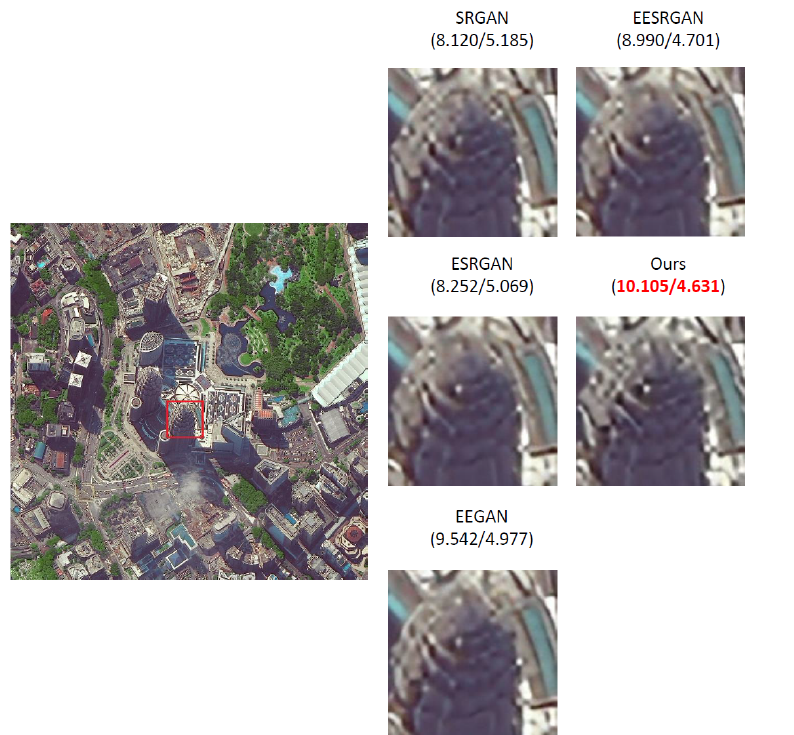
Figure 14. An enlarged partial view of the SR result of each method in the SpaceWill dataset—sample image 1, where the best results are shown in red font.